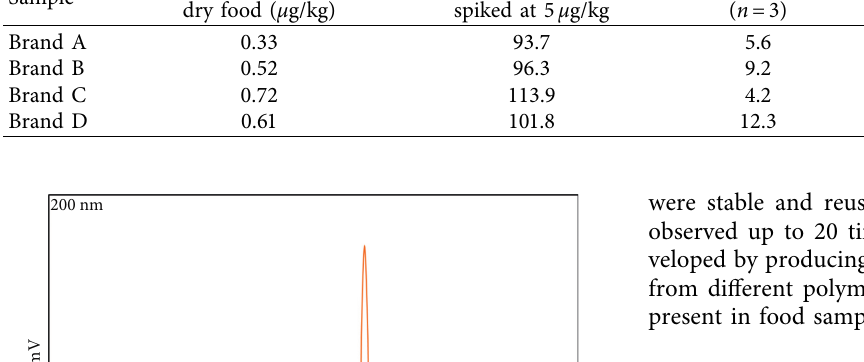
Table 2: Concentration of acrylamide from real samples and the extraction recoveries by nanostructured membrane microextraction. Concentration in Sample